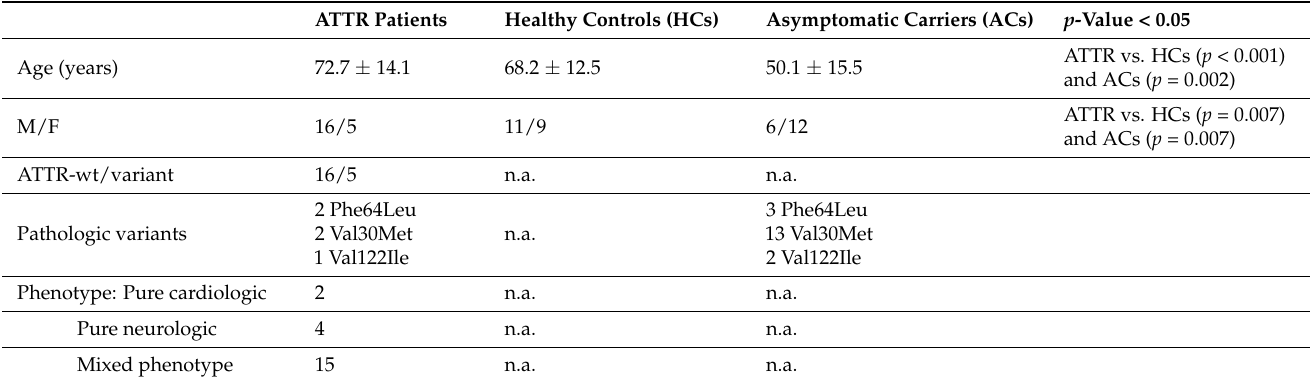
Table 1. Demographic data from the three participant cohorts. n.a.: not applicable. ATTR Patients Healthy Controls (HCs) Asymptomatic Carriers (ACs)